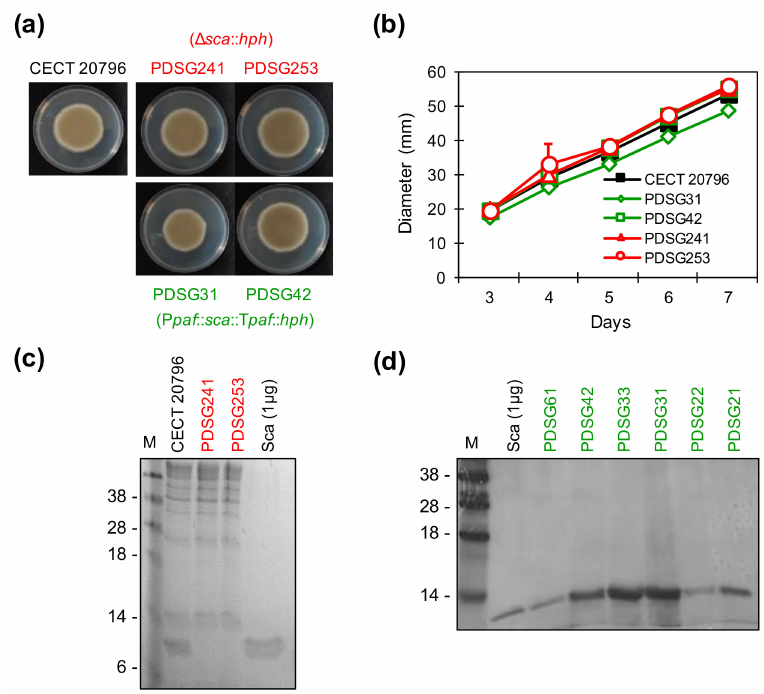
Figure 3. Characterization of di ff erent Penicillium digitatum sca null and overproducer strains. ( a ) Images of PDA plates after 5 days of growth of P. digitatum CECT 20796, null ∆ sca strains (PDSG241 and PDSG253, in red) and Sca op strains (PDSG31 and PDSG42, in green). ( b ) Colony diameter on PDA plates from 3 to 7 days of the same strains represented as the mean ± SD of three replicates. ( c ) SDS-PAGE of 10 × supernatants of P. digitatum CECT 20796 and null ∆ sca strains (PDSG241 and PDSG253) grown in PDB for 11 days. Pure Sca protein (1 µ g) was used as control. Note that the band corresponding to the Sca protein disappeared in these mutants. ( d ) SDS-PAGE of 8-day non-concentrated P. digitatum minimal medium (PdMM) supernatants of di ff erent P. digitatum Sca op strains compared with 1 µ g of pure Sca protein. M: SeeBlue ® pre-stained protein